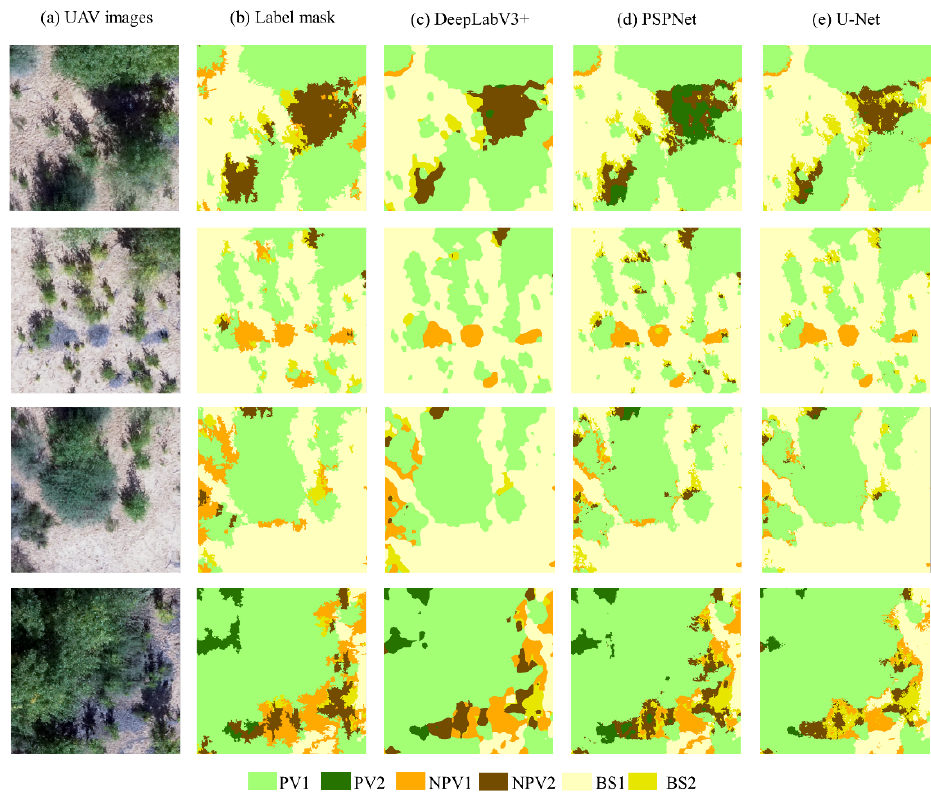
Figure 6. Estimation results under different semantic segmentation models for the test set data. (a) Original images; (b) Label masks; (c) Estimation results by DeepLabV3+; (d) Estimation results by ( a ) Original images; ( b ) Label masks; ( c ) Estimation results by DeepLabV3+; ( d ) Estimation results by PSPNet; (e) Estimation results by U-Net. PSPNet; ( e ) Estimation results by